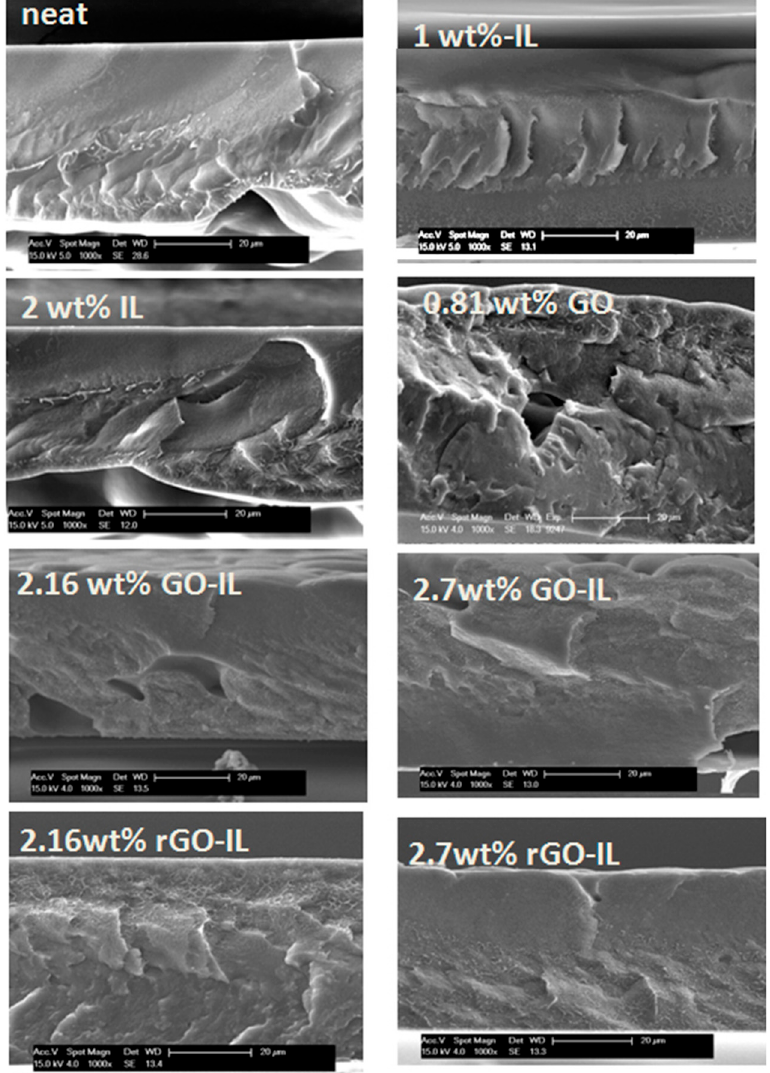
Figure 9. SEM images of fractured cross-sections of composite films containing IL, GO, GO-IL, and rGO-IL.